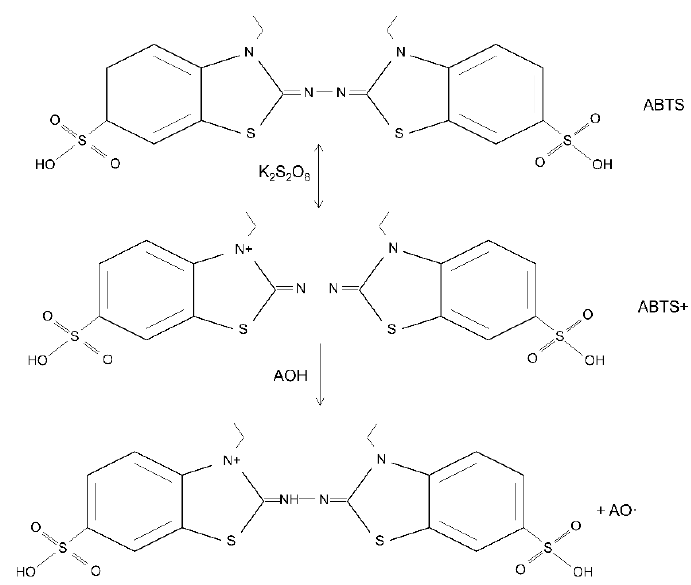
Figure 7. The interaction of ABTS assay when the antioxidant agent is present. The image is adapted from Bedlovicova et al. [174] and license under CC BY 4.0.